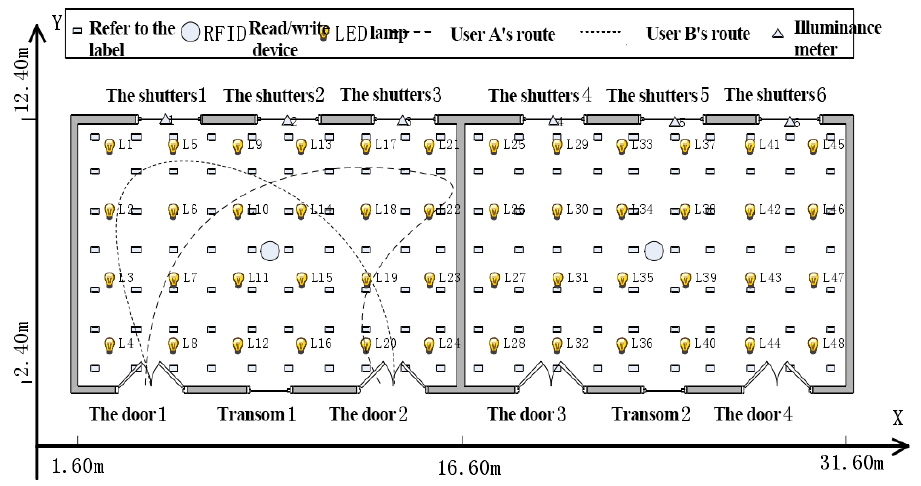
Figure 10. Experimental equipment and layout.